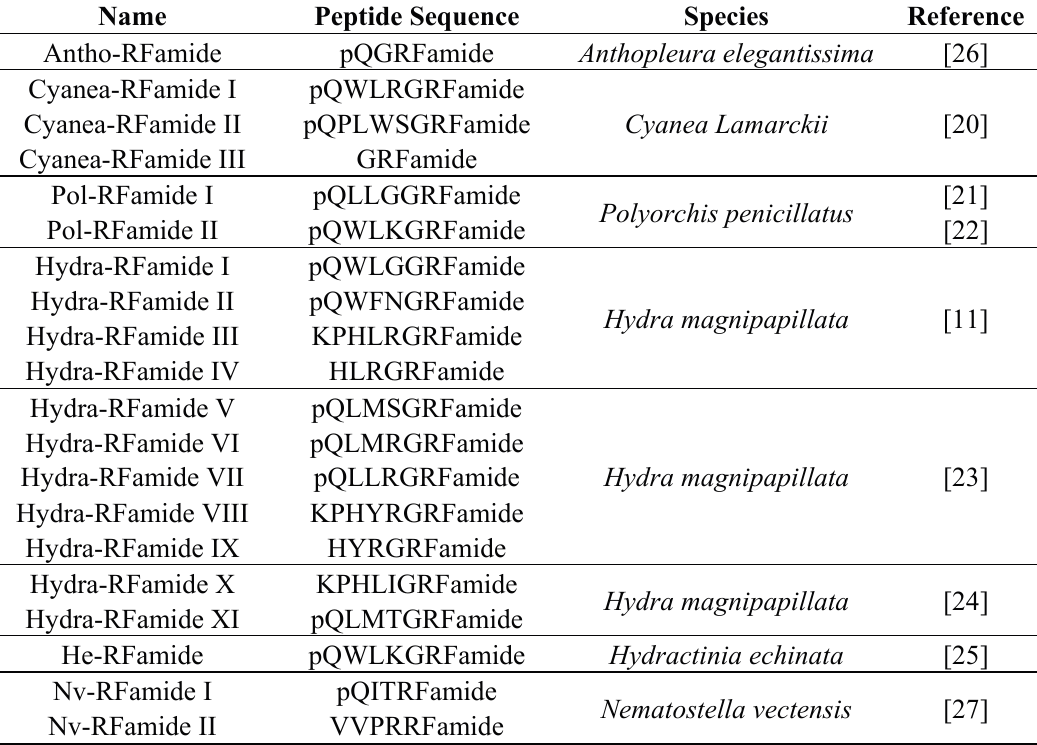
Table 1. FMRFamide-like peptides in